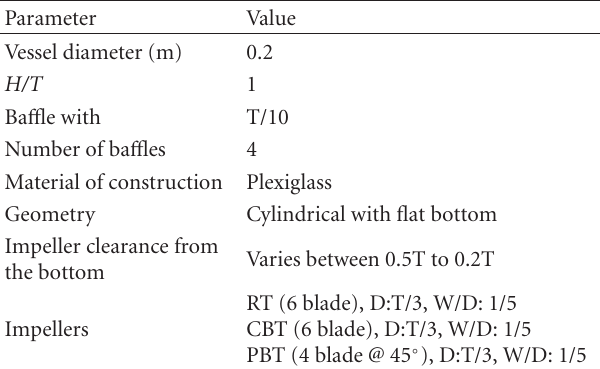
Table 3: Design details of a mechanically stirred